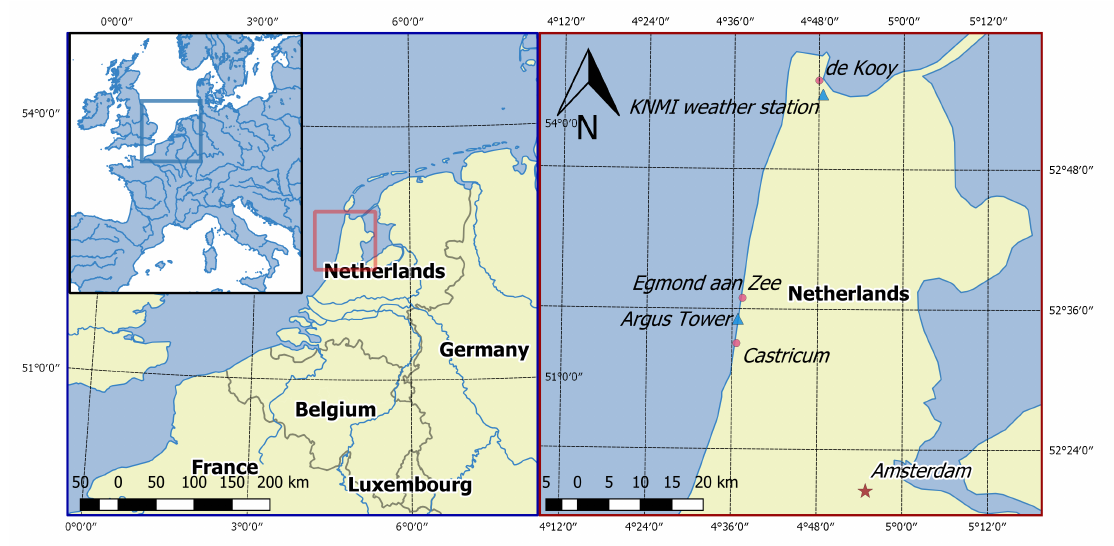
Figure 1. Map of the field site and weather station.